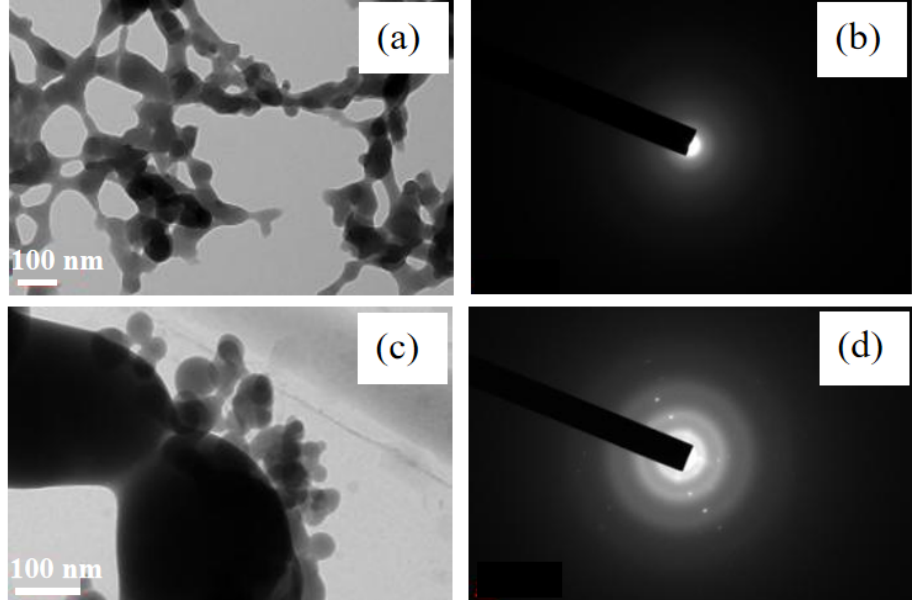
Figure 4. ( a ) TEM image of the precipitate-As(III); ( b ) SAED image of the precipitate-As(III); ( c ) TEM image of the precipitate-As(V); ( d ) SAED image of the precipitate-As(V).